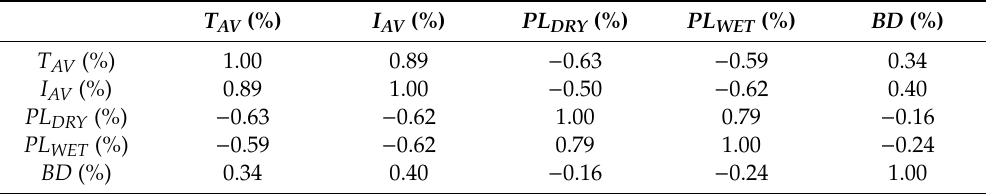
Table 9. Correlation coe ffi cients of the di ff erent response variables.